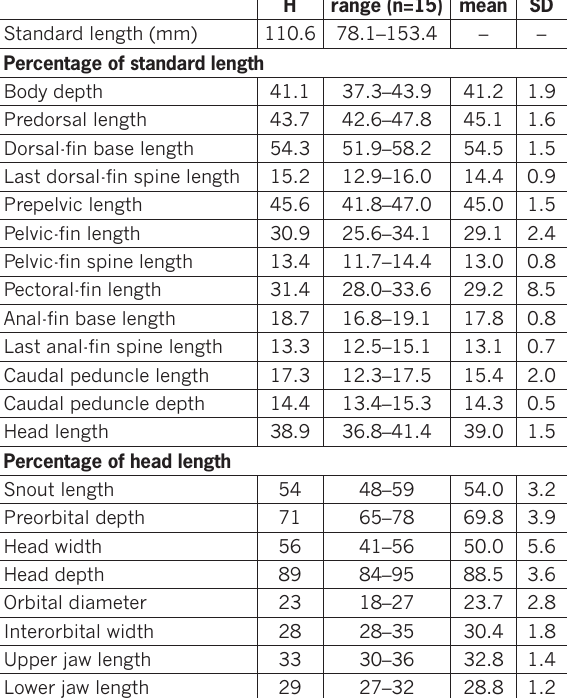
Table 4. Morphometric data of G . santosi . H, holotype; SD, standard deviation. Values of Holotype included in range.